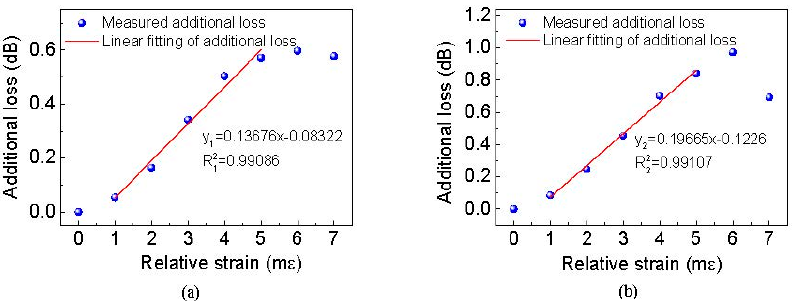
Figure 5. Additional loss induced by strain sensor as a function of relative strain. ( a ) Sensing point one, ( b ) sensing point